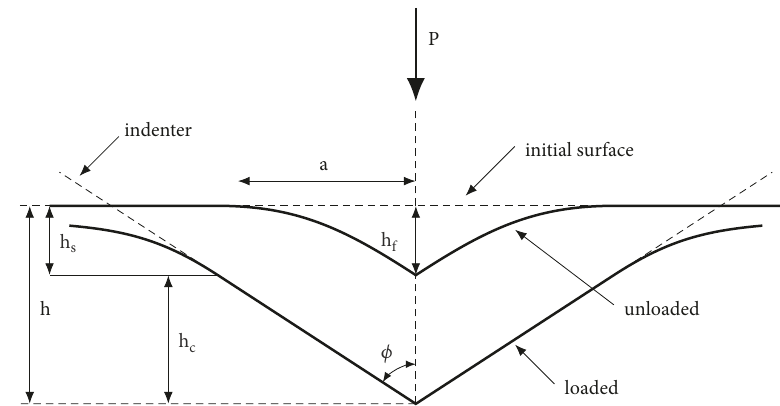
Figure 4: Ideal indentation depicting ℎ 𝑐 and the initial linear portion of the unloading stage where stiffness is calculated.